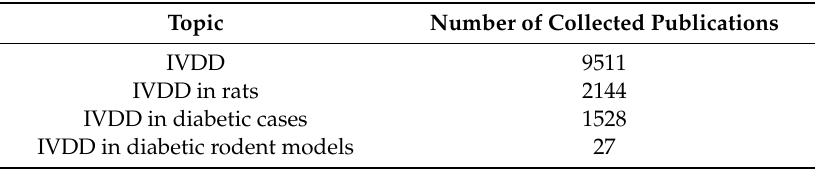
Table 1. Classification of the totally collected manuscripts up to May